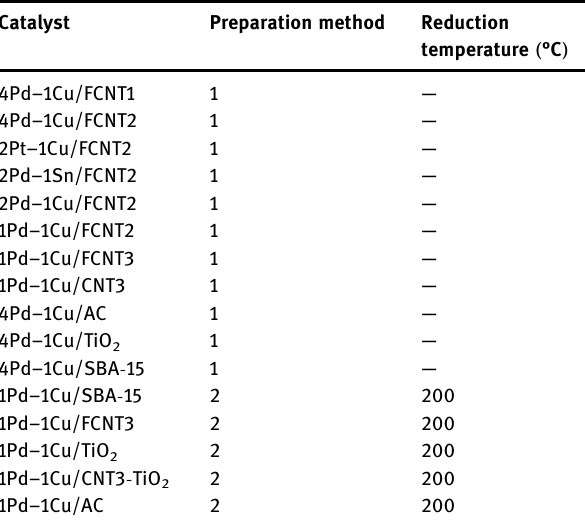
Table 1: The prepared catalysts and their preparation